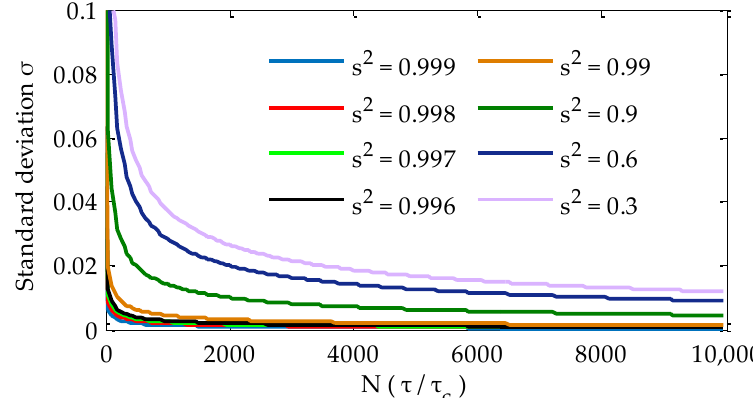
Figure 9. Standard deviation σ I of the normalized intensity ratio as a function of the smoothing time with different correlation coefficients.